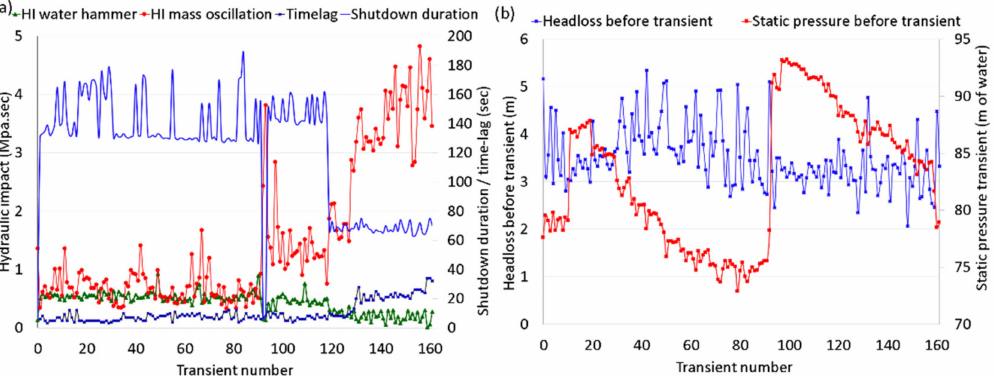
Figure 11. HI for BH4 during various transients in chronological order ( a ) and corresponding discharge change magnitude and static pressure before transient ( b